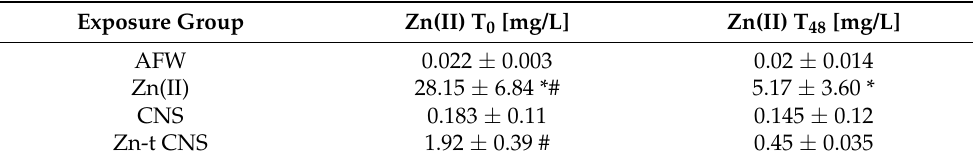
Table 2. Zn(II) concentration (mg/L) in zebra mussels’ exposure waters at time zero (T 0 ) (soon after preparation and expoScheme 48 h (T 48 ) for AFW (control); Zn(II) 50 mg/L in AFW; Zn-t CNS (Zn(II) 50 mg/L contaminated AFW treated with CNS), CNS (AFW treated with CNS only). Data are reported as mean ± SD from three independent experiments. (*) p < 0.05 respect to control within the same exposure time (#) p < 0.05 comparison between the two exposure times. Exposure Group Zn(II) T 0 [mg/L] AFW